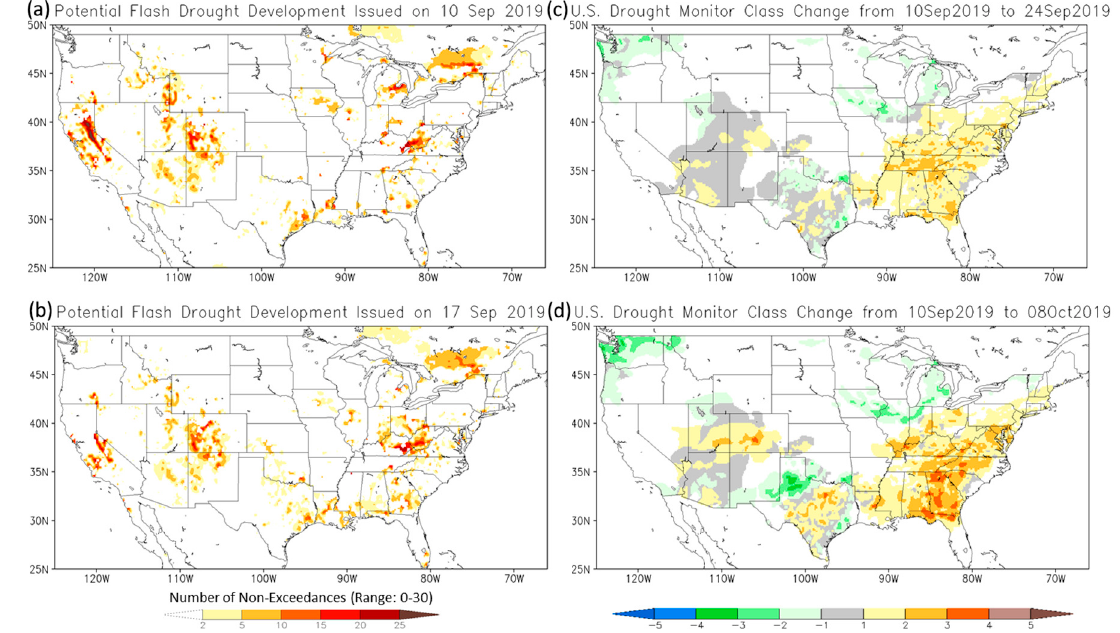
Figure 11. ( a , b ) show the potential flash drought development issued on 10 and 17 September 2019 and ( c , d ) are the USDM class change maps from 10 to 24 September and 8 October 2019.